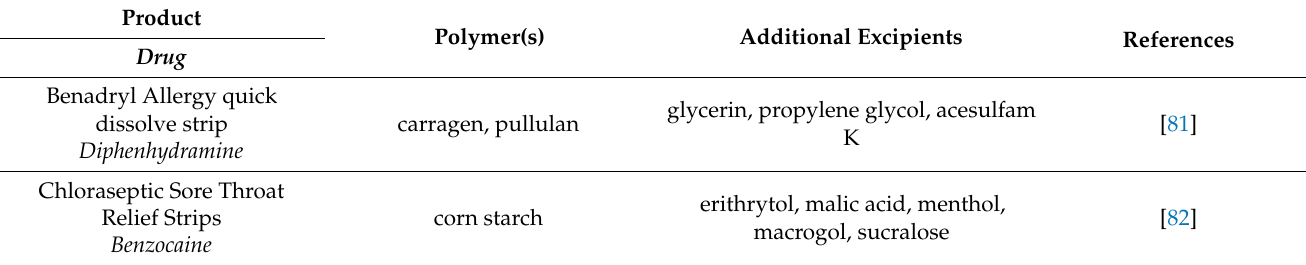
Table 5. Exemplary ODFs accessible as OTC or Rx